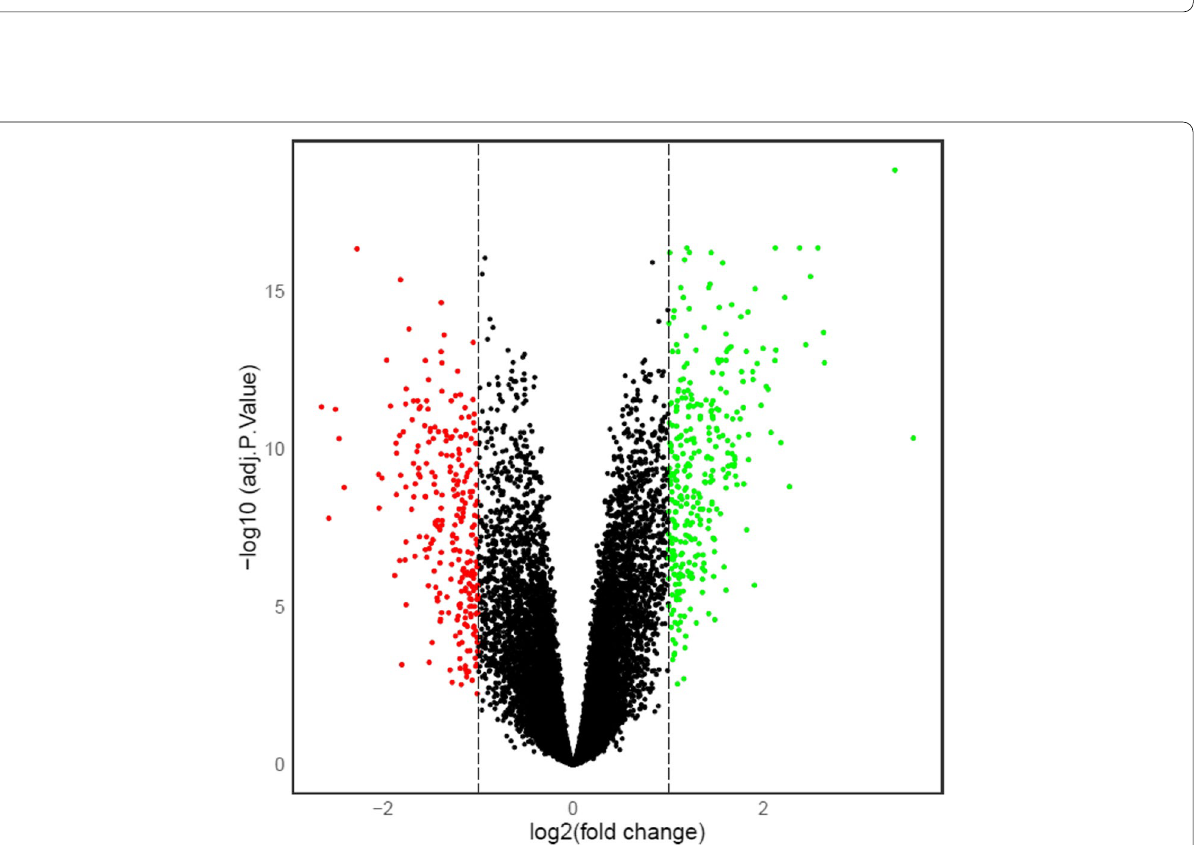
Fig. 2 Volcano plot visualizing the DEGs in a total of 22,189 genes; green points represent 323 upregulated and red represents 253 down‑regulated